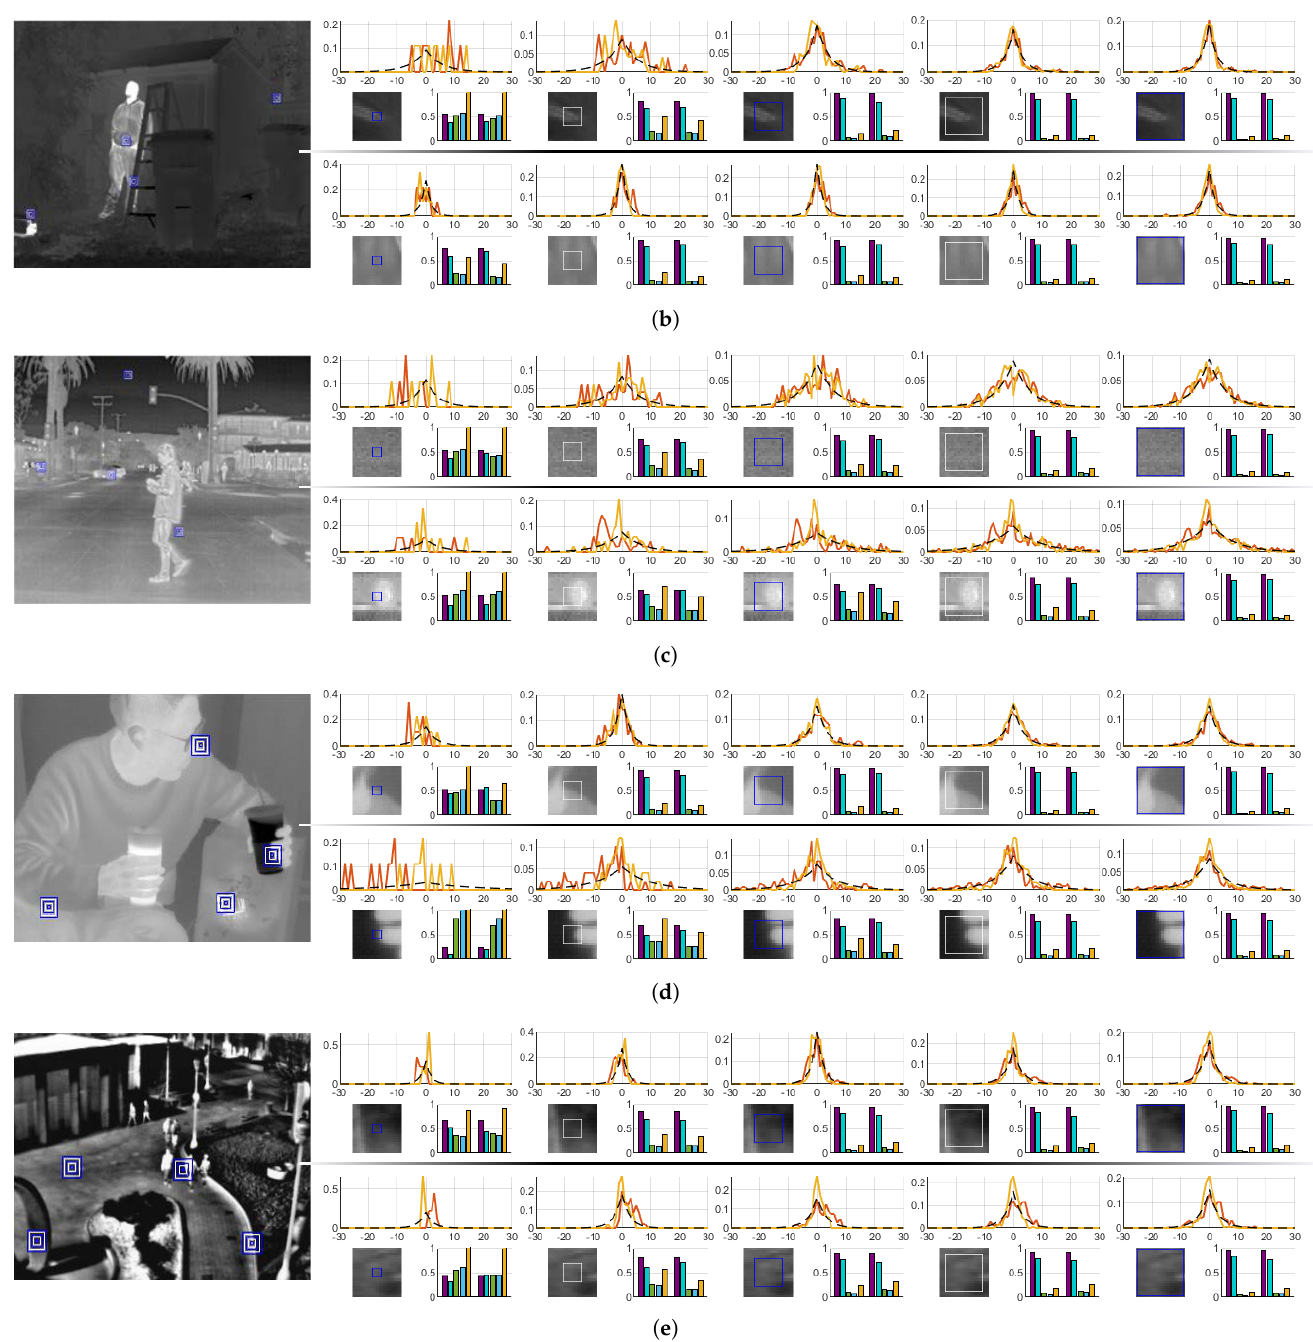
Figure 5. The validity of our hypothesis with varying patch sizes. The distribution of high-frequency components can be clearly estimated by the Laplace distribution as the size of the patch increases. Note that the measure scores over 1 were clipped for clear demonstration. ( a ) MORRIS [1]; ( b ) KRISTO [19]; ( c ) FLIR ADAS [5]; ( d ) SRIP; ( e ) OSU